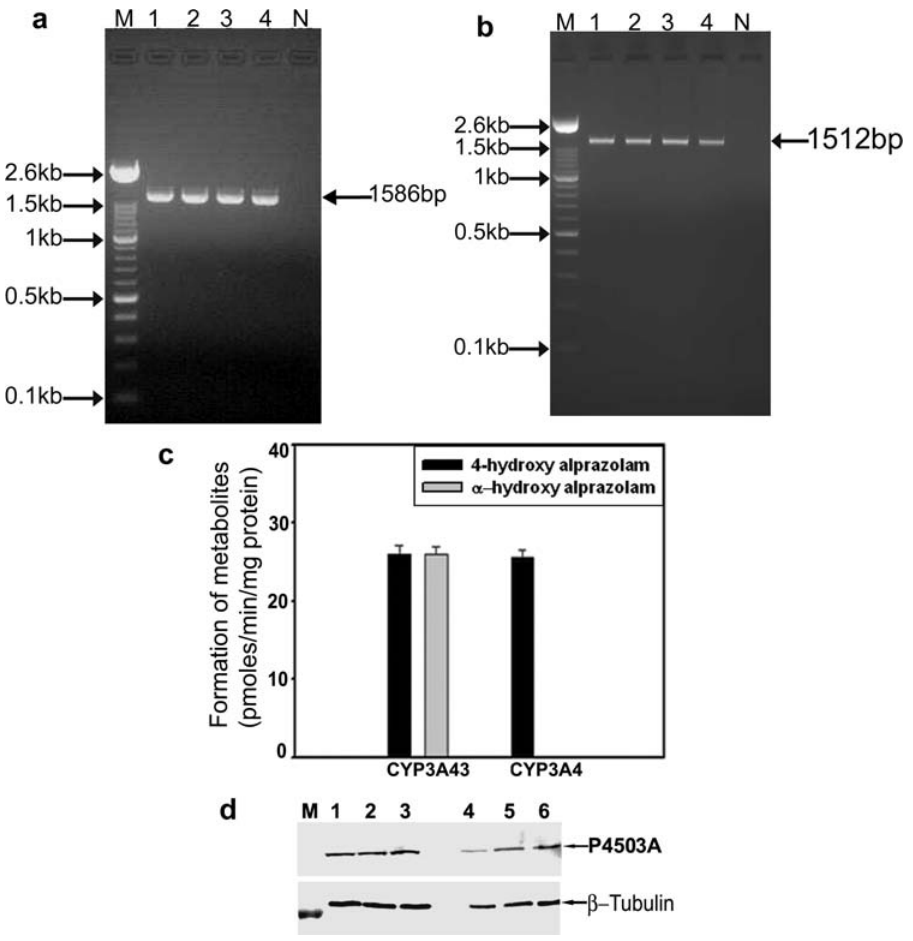
Figure 5. Cloning and expression CYP3A43 and CYP3A4 and metabolism of alprazolam, in vitro by recombinant enzymes. The complete open reading frame of CYP3A43 and CYP3A4 were amplified by RT-PCR using total RNA from four autopsy human brain samples. The amplicons of 1586bp and 1512bp were generated for CYP3A4 and CYP3A43, respectively (a, and b, from lanes 1–4). M represents 100bp ladder and Ne, the control reaction performed without template DNA. The amplicons were cloned into pcDNA 3.1 for expression in COS-1 cells. (c) Recombinant CYP3A43 metabolized alprazolam to a -OHALP and 4-OHALP in similar amounts (26 pmoles/min/mg protein), while recombinant CYP3A4 metabolized alprazolam only to 4-OHALP. The values are mean ISD (n=3 independent experiments). (d) Immunoblot of recombinant CYP3A43 and CYP3A4 normalized using b -tubulin.